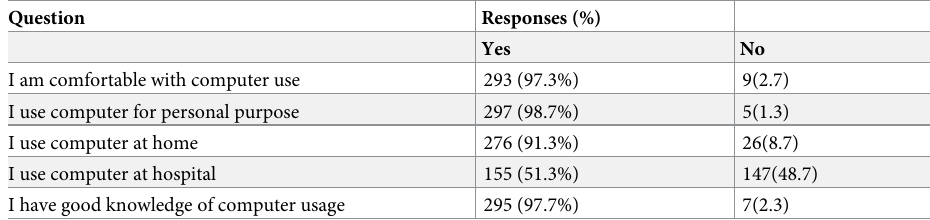
Table 2. Response of physician on current computer usage status (N = 302).